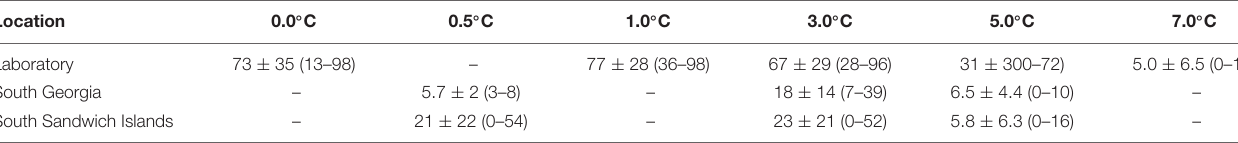
TABLE 3 | Effect of temperature on hatching success from both field and laboratory experiments.